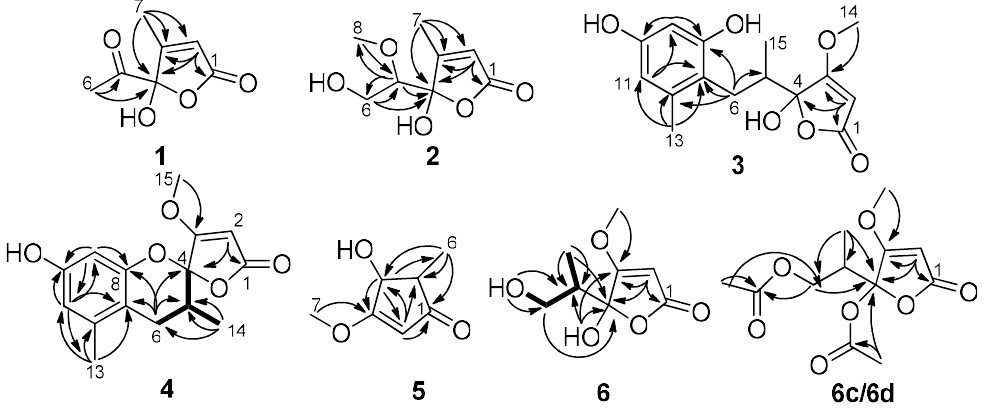
Figure 2. Key COSY and HMBC correlations of 1 – 6 , 6c and 6d.